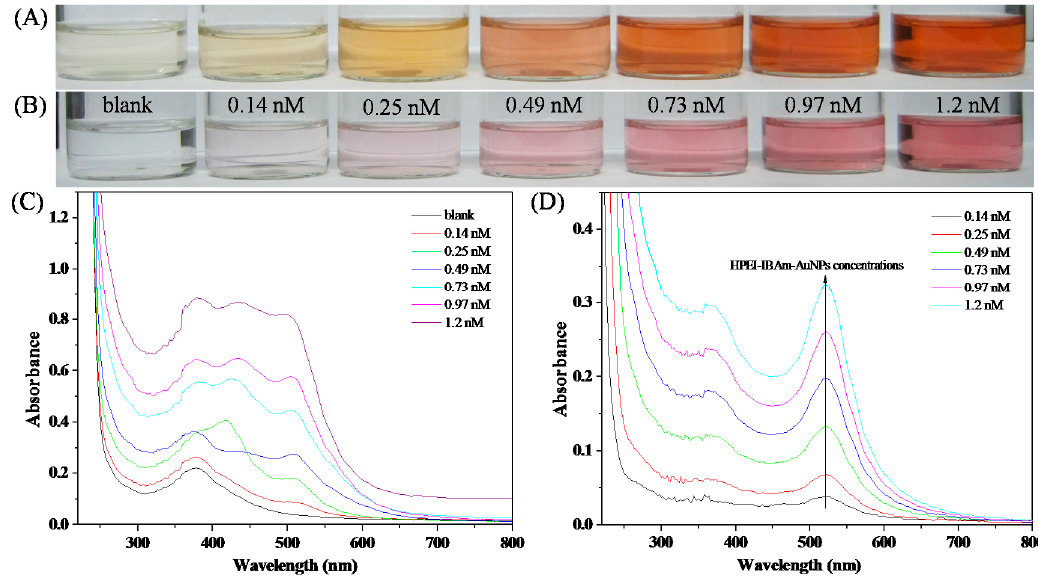
Figure 8. Photographs of HPEI-IBAm-AuNPs with different concentrations in the presence ( A ) and absence ( B ) of 0.573 mM Ag + ; UV-vis absorption spectra of HPEI-IBAm-AuNP solution with different concentrations in the presence ( C ) and absence ( D ) of 0.573 mM Ag + .